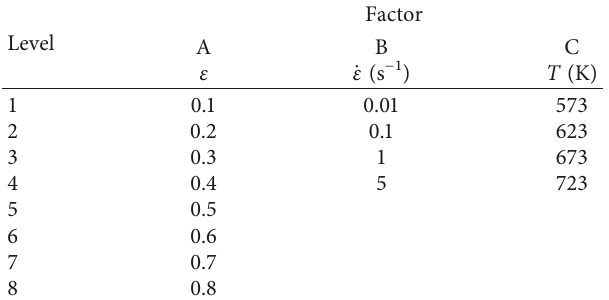
Table 4: ANOVA (analysis of variance) table of the AA6061 alloy under PSC.